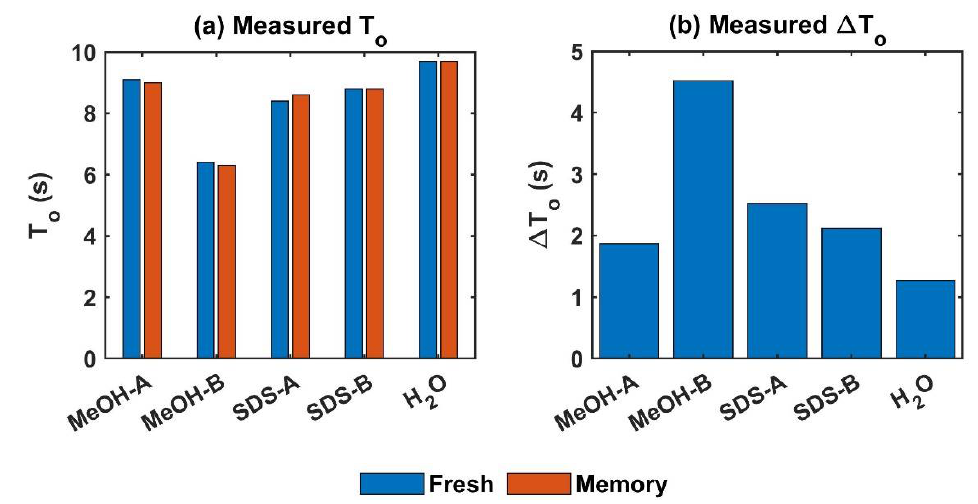
Figure 3. To and subcooling measurements for MeOH (1 wt% and 5 wt%) and SDS (50 ppm and 100 ppm) at Pi = 80 bar. ( a ) To measurement for CH 4 hydrate in the presence of MeOH and SDS at different concentrations. ( b ) Measurement of supercooling of CH 4 hydrate in the presence of MeOH and SDS at different concentrations. Table 2. Information on dissociation temperature T d ( ◦ C) in the presence of MeOH, SDS, and water under 80 bar. T d − T o ( ◦ C) indicates the difference between dissociation temperature (T d ) and onset nucleation temperature (T o